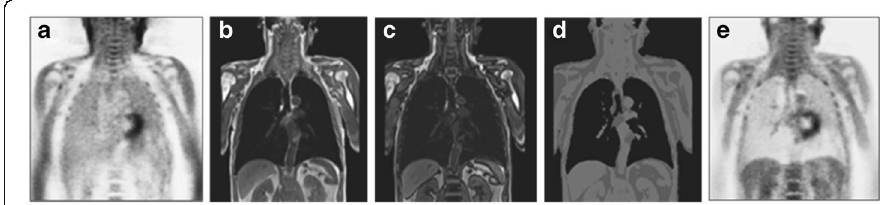
Fig. 1 Soft-tissue attenuation correction (AC) of 18 F-FDG PET images based on MRI. (A) Uncorrected thoracic PET scan showing relative activity enhancement in the lungs and along the outer contours of the patient. (B and C) 3D Dixon volume interpolated breath-hold examination (VIBE) MR sequence providing separate water/fat “ in-phase ” and “ opposed-phase ” images that serve as basis for soft-tissue segmentation. (D) Segmented soft tissue groups (air, fat, muscle, lungs) that can be assigned to a 3D PET attenuation map. (E) Resulting attenuation corrected PET scan of the initial data set (A). Note: Bone signal is assigned soft tissue values in this MRI-based approach for